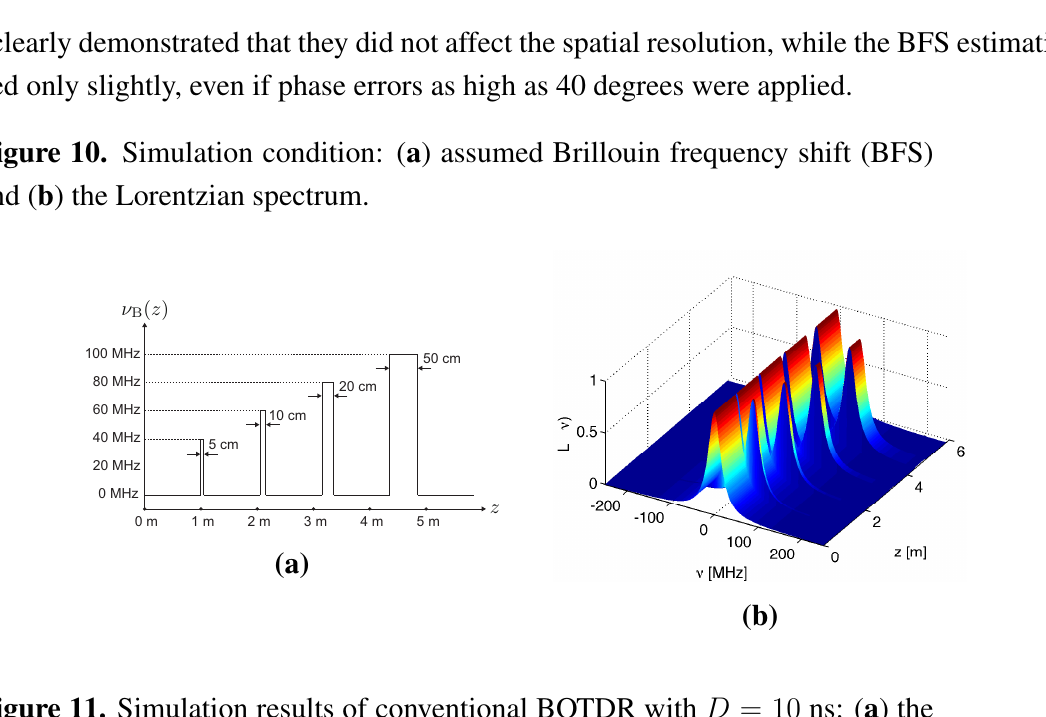
Figure 11. Simulation results of conventional BOTDR with D = 10 ns: ( a ) the Brillouin spectrum and ( b ) the estimate of BFS.